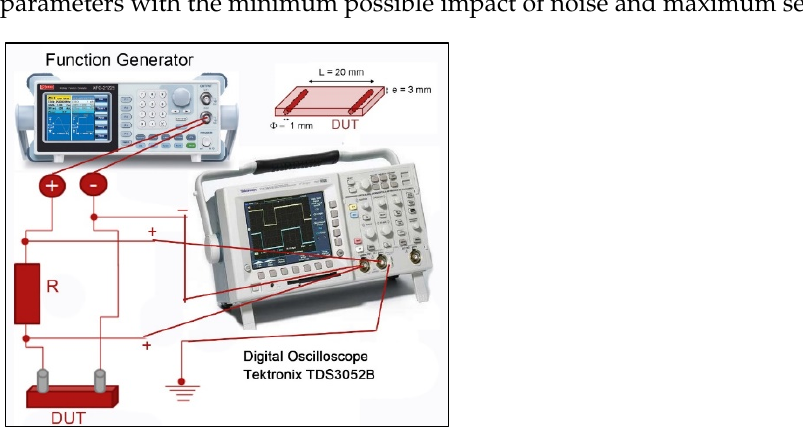
Figure 2. Scheme of the equipment configuration used to study the absorption of electromagnetic waves.